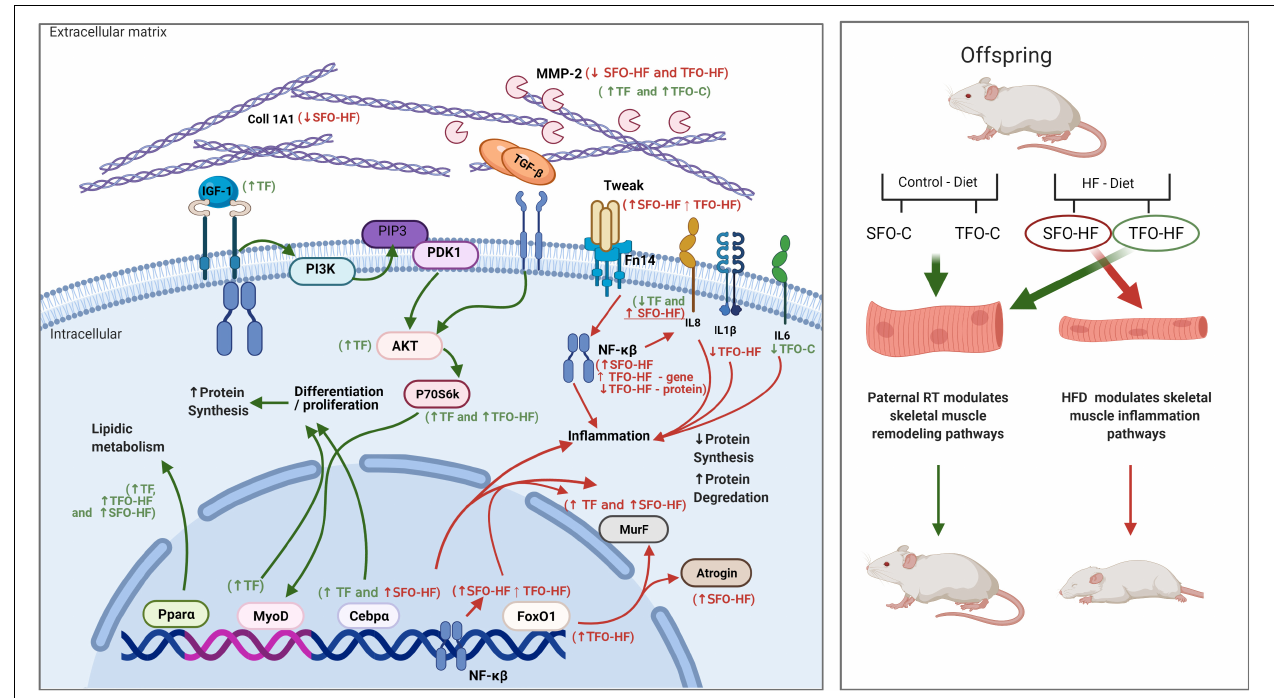
FIGURE 8 | Overview of skeletal muscle remodeling pathways in the gastrocnemius muscle of fathers and male offspring exposed to control diet and